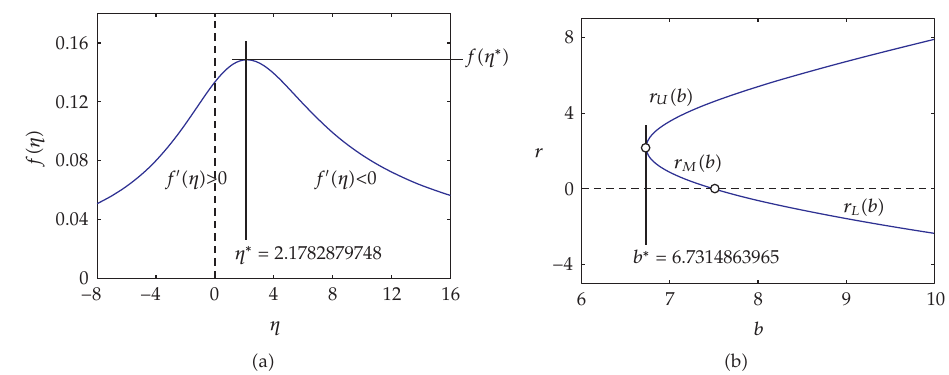
Figure 1: (cid:2) a (cid:3) Graph of function f (cid:2) η (cid:3) ; (cid:2) b (cid:3) phase diagram of nematic